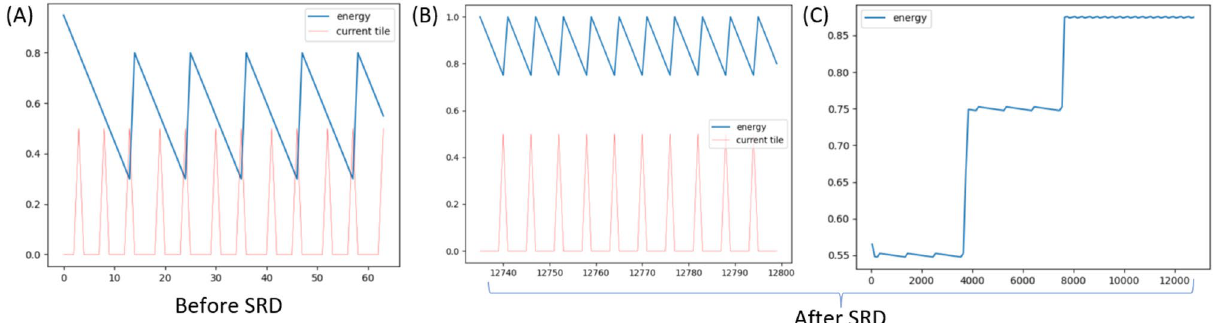
Figure 3. ( A ) plot of energy ( F , blue) and food availability (red) for untrained model. SRD-trained model at its